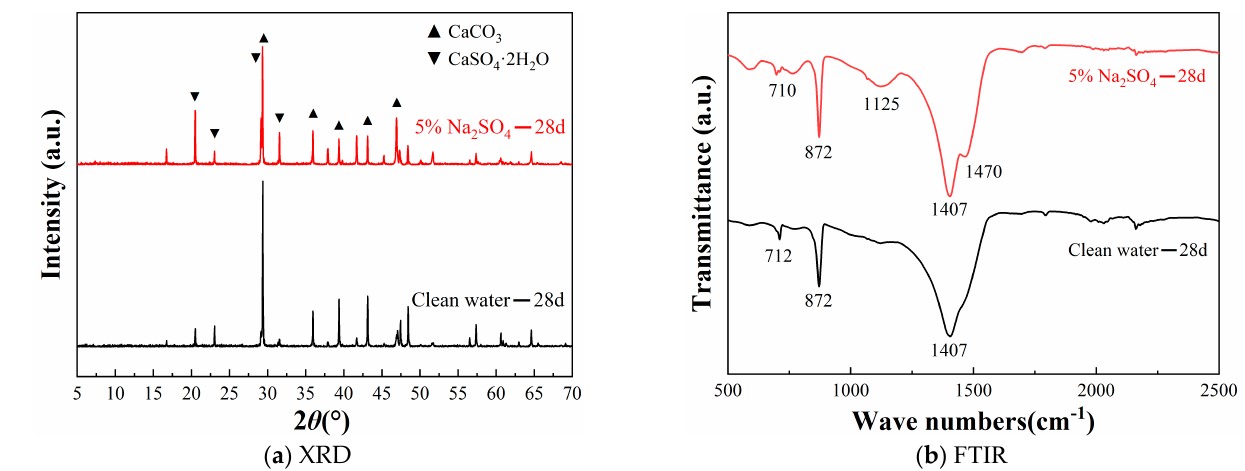
Figure 19. XRD&FTIR patterns of self-healing products.